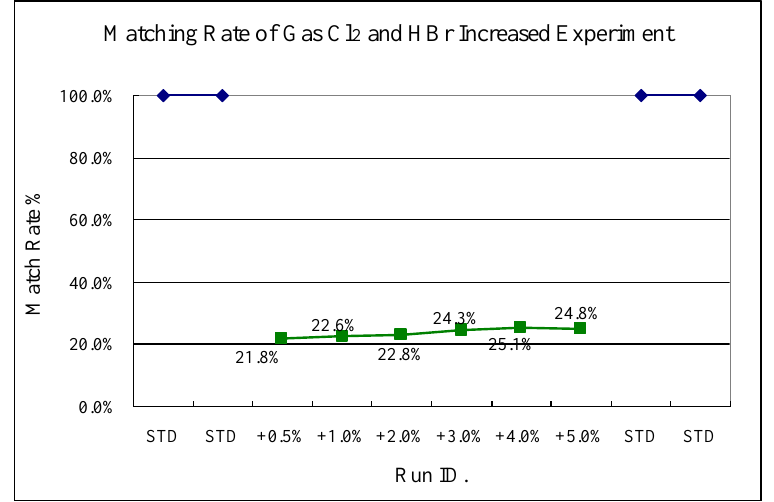
Figure 13. Experiment 4, Cl 2 and HBr increased at the same time tested (Cl to 52.25 sccm, STD = 50 sccm; HBr from 251.25 to 262.5 sccm; STD = 250 sccm).